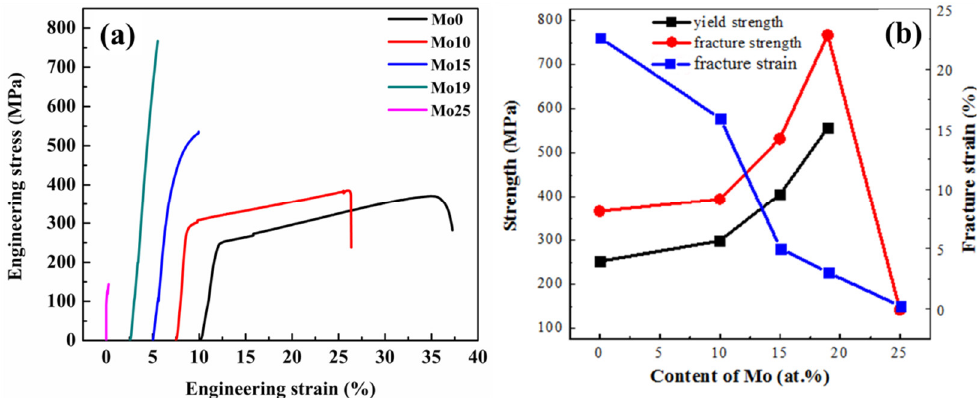
Figure 6. Tensile properties of (CoCuFeNi) 100- x Mo x alloys at room temperature. ( a ) Stress vs. strain curves of (CoCuFeNi) 100- x Mo x alloys. ( b ) The yield strength, fracture strength and fracture strain vs. the content of Mo.